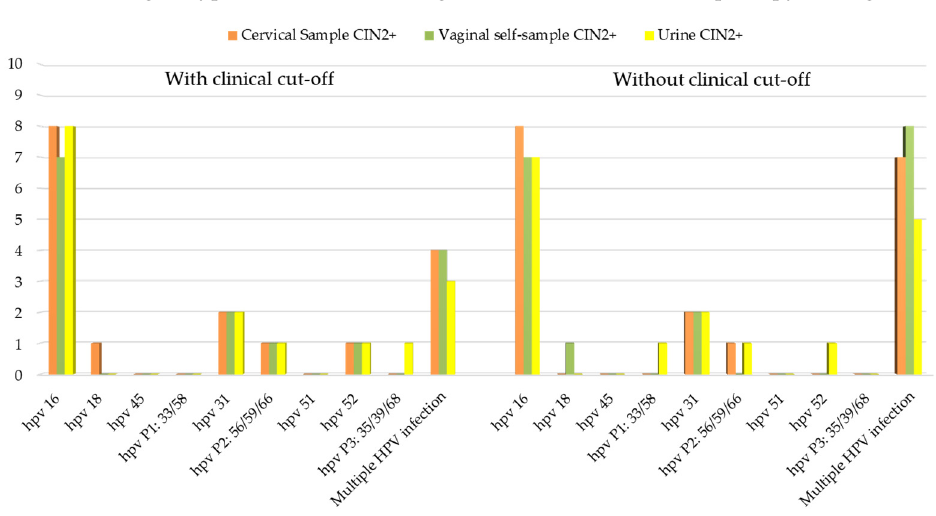
Figure 4. HPV genotypes’ distribution among women with CIN2+ lesions.